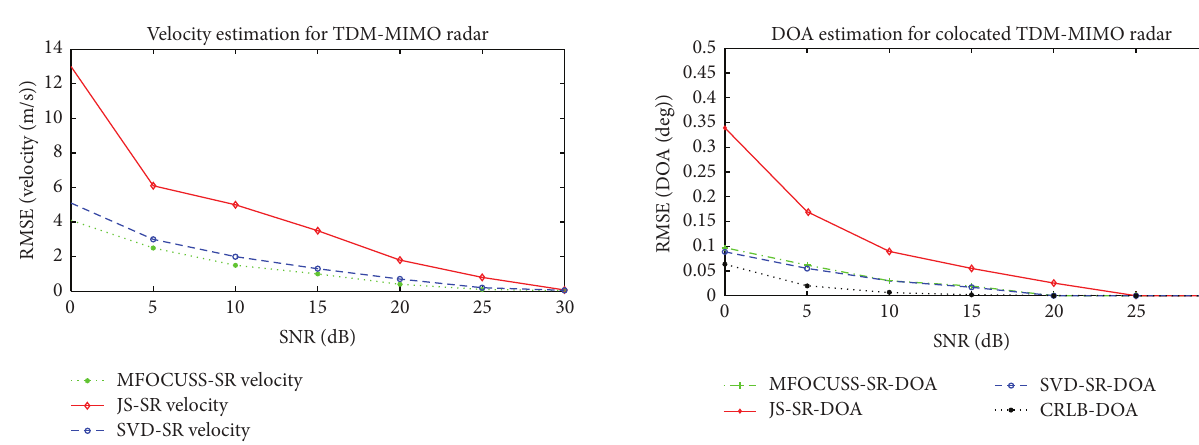
Figure 7: DOA estimation for TDM-MIMO radar.